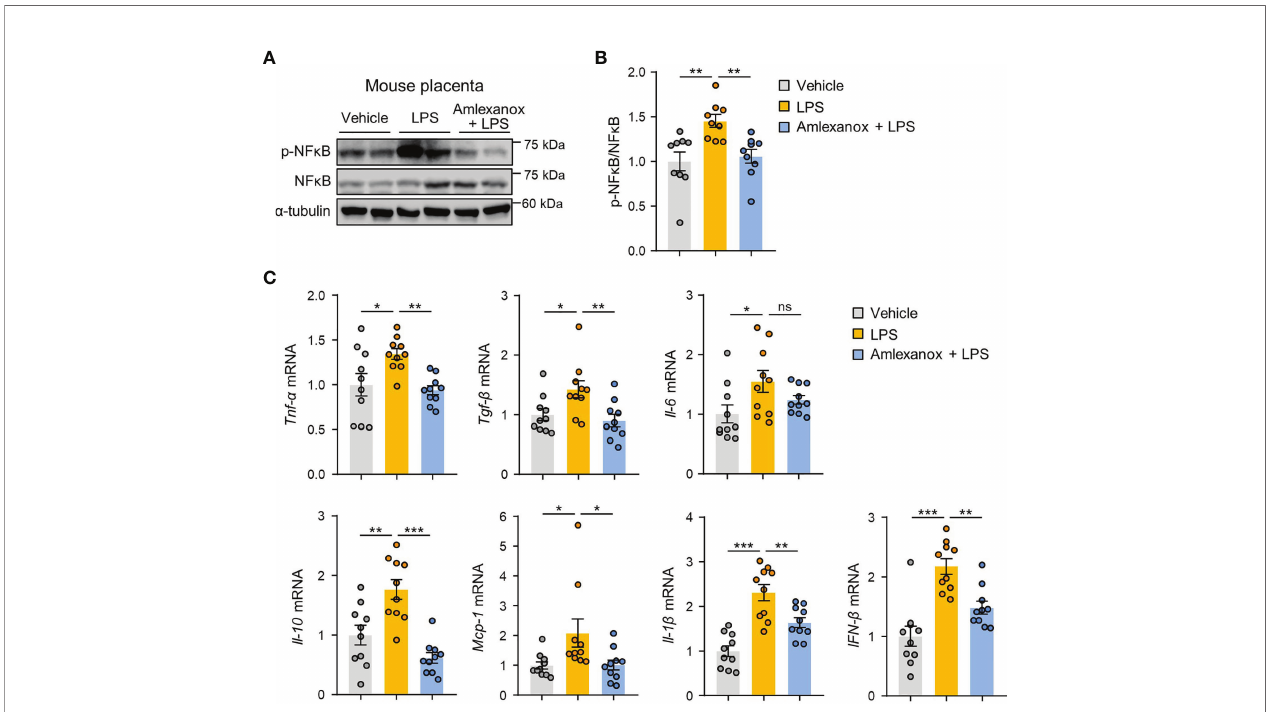
FIGURE 6 | Amlexanox ameliorates LPS-induced in fl ammatory response in mouse placenta. (A – C) Pregnant mice were intraperitoneally injected with LPS (200 m g/ kg) or amlexanox (2.5 mg/kg) on gestation day 17.5, as indicated in the fi gure. (A, B) Placental tissues were collected from mice and analyzed by immunoblotting with anti-p-p65 and anti-p65 antibodies ( n = 9 per group). a -tubulin served as a loading control. Band intensities were quanti fi ed and normalized to control band intensities. (C) Placental tissues were collected from mice and analyzed by qRT-PCR for the expression of TNF- a , TGF- b , IL-6, IL-10, MCP-1, IL-1 b , and IFN- b ( n = 10 per group). Data are shown as means ± SEM. * p < 0.05; ** p < 0.01; *** p < 0.001; ns, not signi fi cant (One-way ANOVA, followed by Fisher ’ s LSD